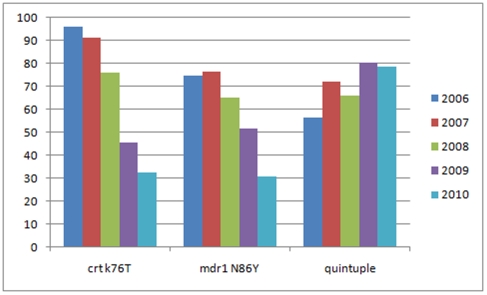
Prevalence of quintuple, crt76Tand mdr186Y mutations (%) in Gaza Province by year.